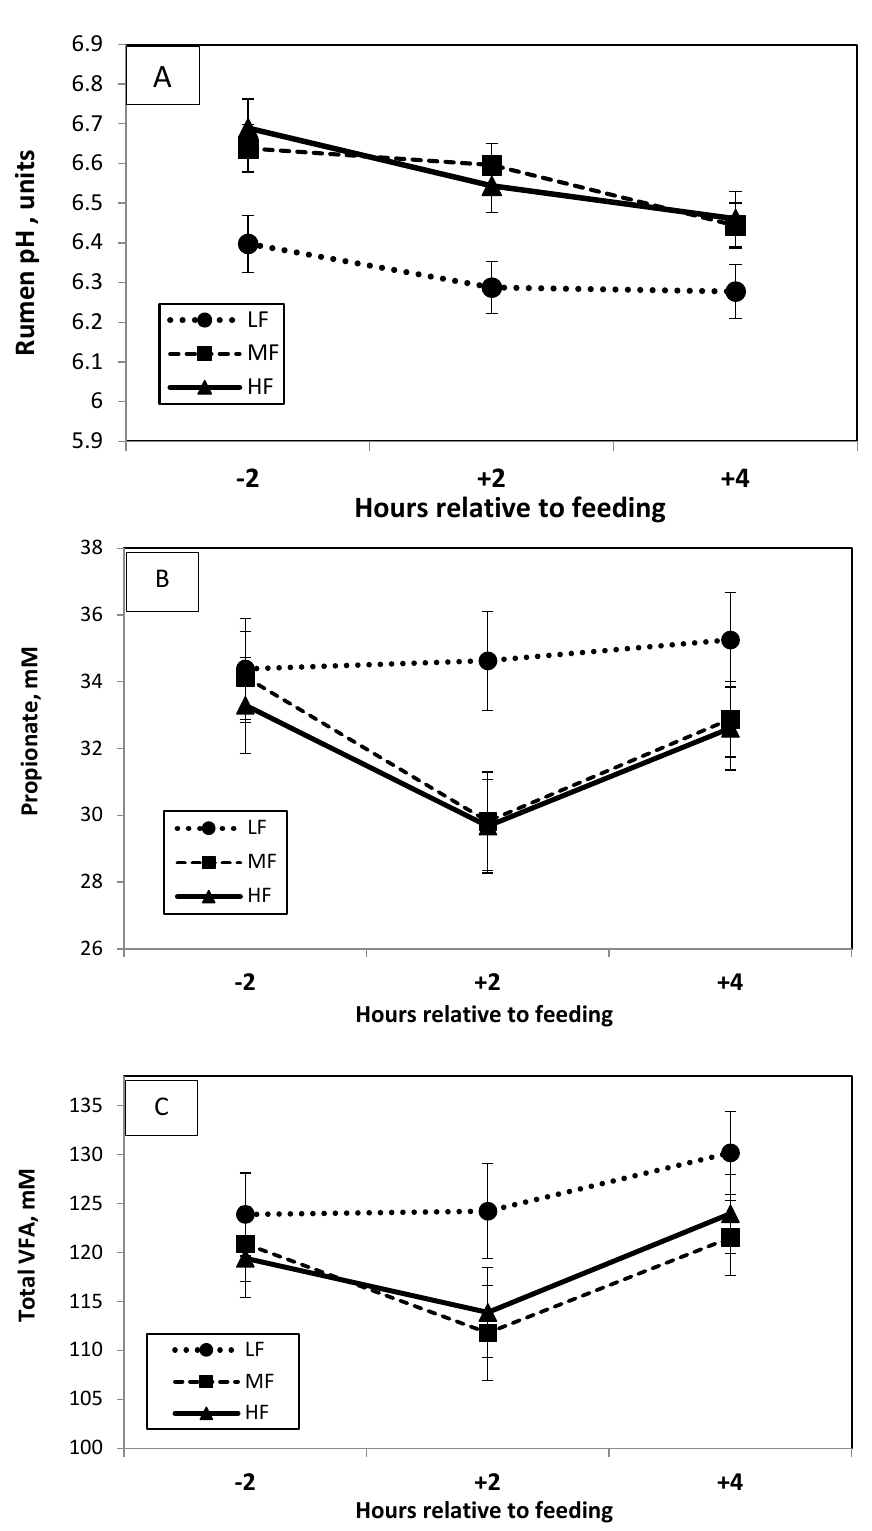
Figure 1. Rumen pH ( A ) and concentrations of propionate ( B ) and total volatile fatty acids (VFA) ( C ) in rumen, plotted against sampling time ( − 2, +2, and +4 h relative to feeding) in dairy cows fed a lactating cow ration containing (i) low fat (LF)—1.7% calcium salts of palm oil fatty acids (CS-PFA) (4.7% total fat in diet), (ii) moderate fat (MF)—2.8% CS-PFA (5.8% total fat in diet), or (iii) high fat (HF)—3.9% CS-PFA (6.8% total fat in diet).